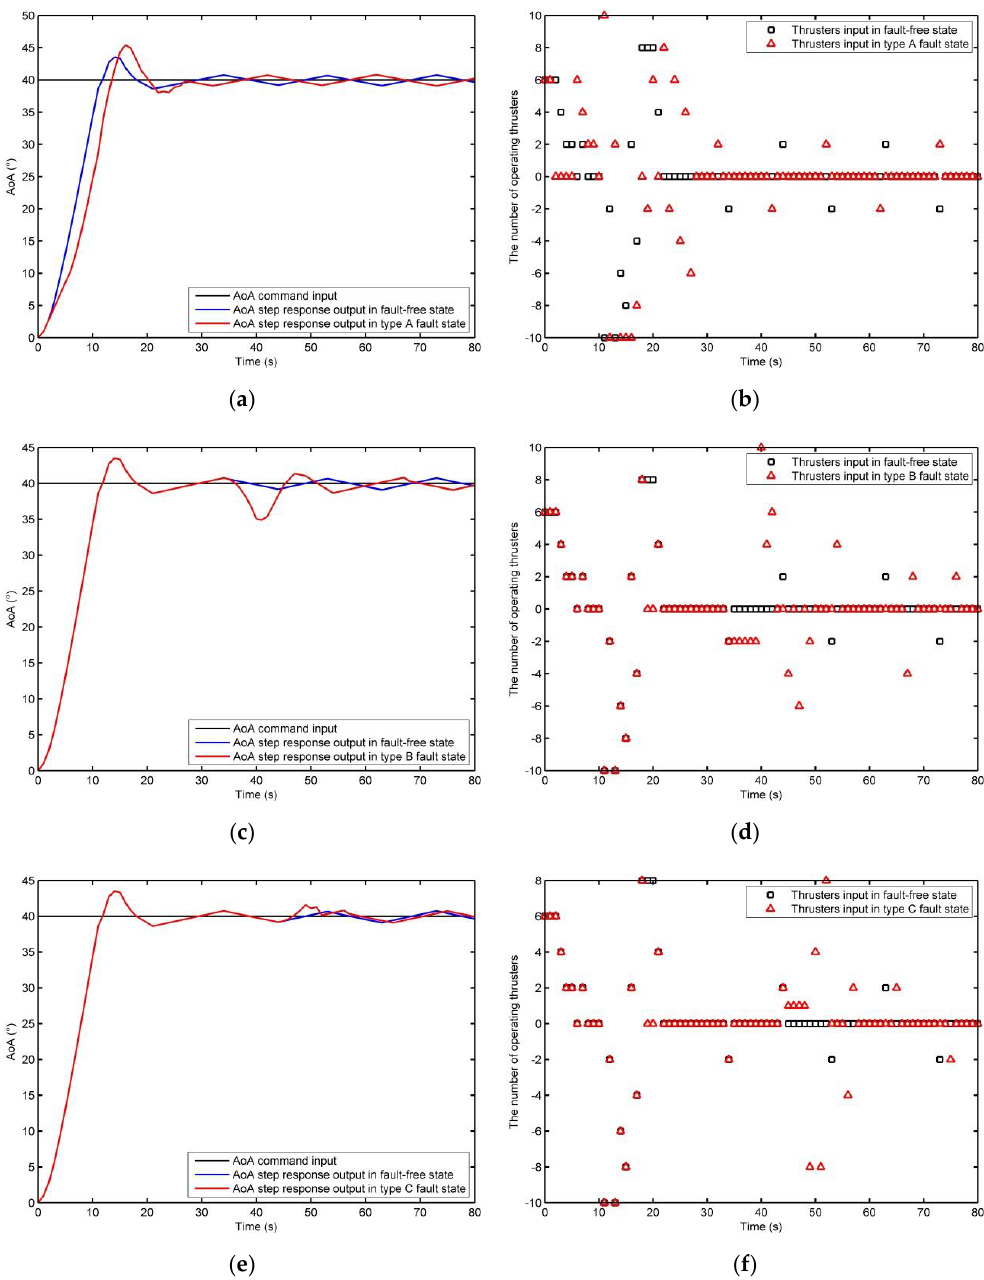
Figure 13. Response output and the number of working thrusters for the type A, B, and C faults and the fault-free state: ( a ) AoA response output for the type A fault and the fault-free state; ( b ) the number of working thrusters in the type A fault and fault-free state; ( c ) AoA response output for the type B fault and the fault-free state; ( d ) the number of working thrusters in the type B fault and fault-free state; ( e ) AoA response output for the type C fault and the fault-free state; ( f ) the number of working thrusters in the type C fault and fault-free